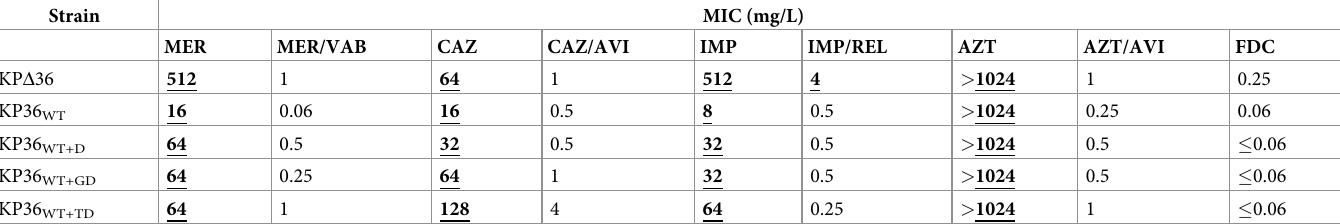
Table 2. Minimum inhibitory concentrations of different antibiotics for isogenic KP